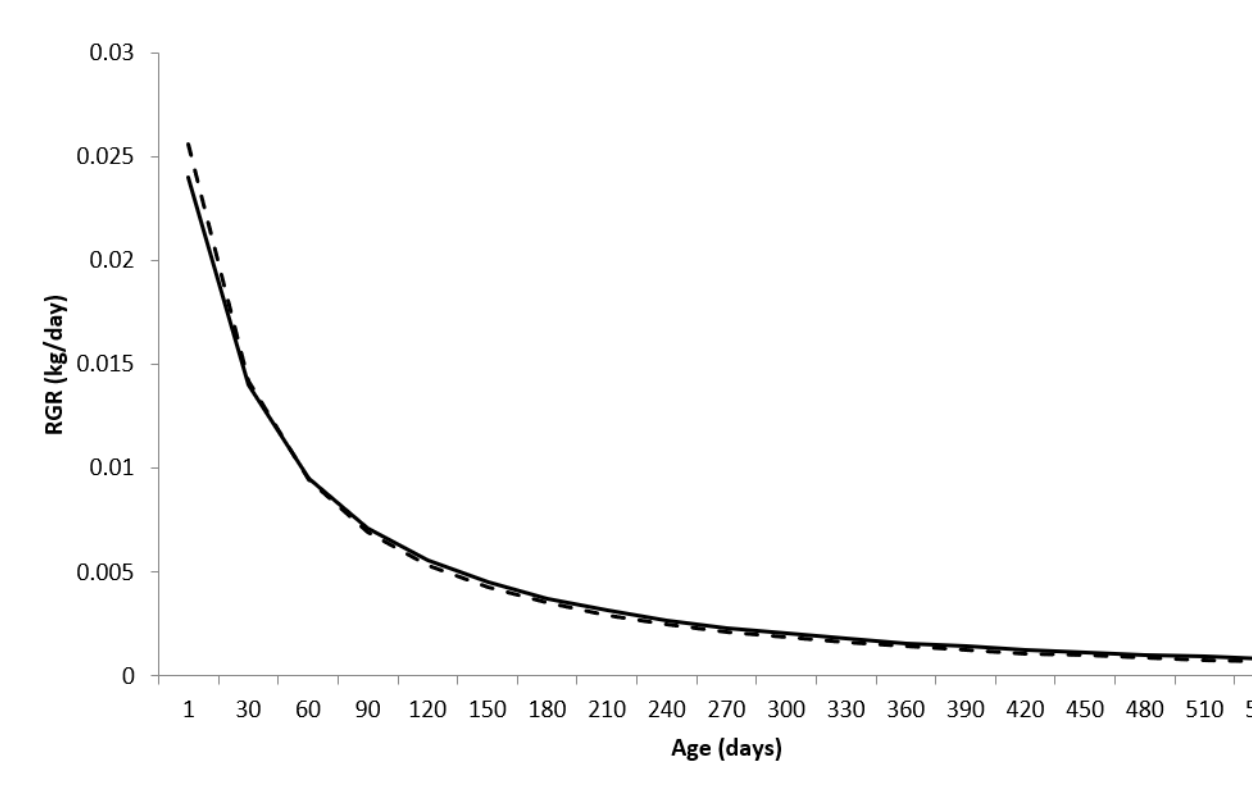
Figure 3. Relative growth rate (RGR) for males ( — ) and females ( ‑‑‑ ) of the Nelore breed, using the Brody function in a mixed nonlinear model.